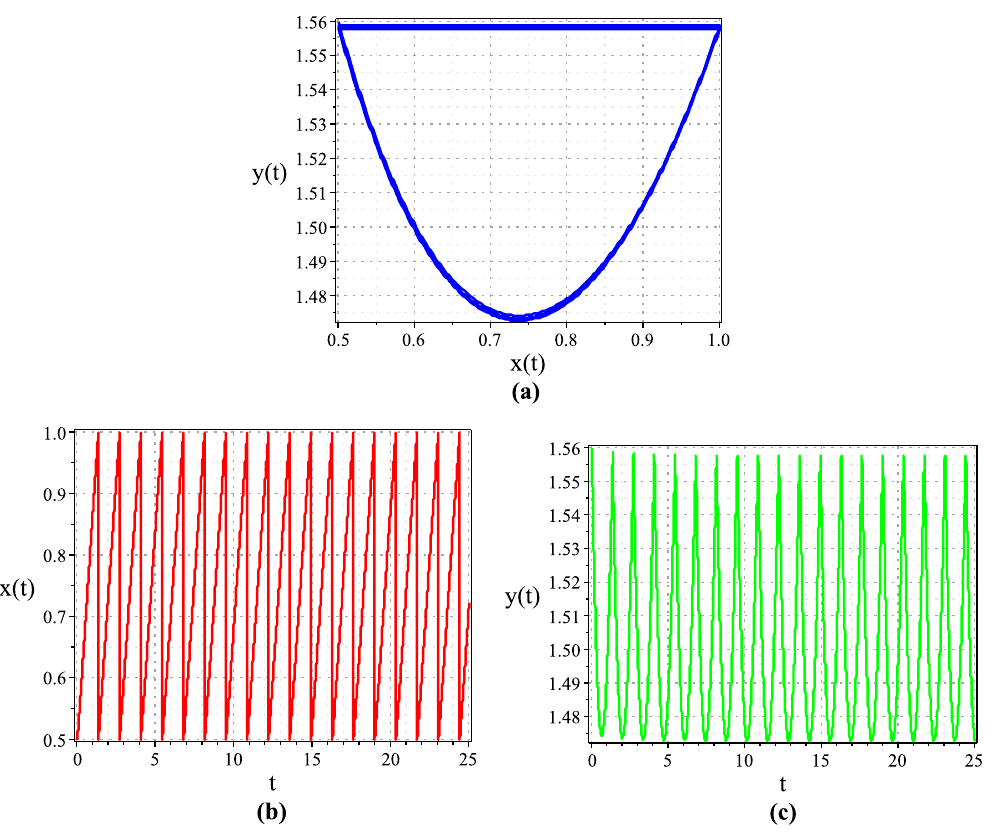
Figure 5. Phase portrait and time series of system (7) with h = 1, v = 0.5. ( a ) Phase portrait of x(t) and y(t). ( b ) Time series of x(t). ( c ) Time series of